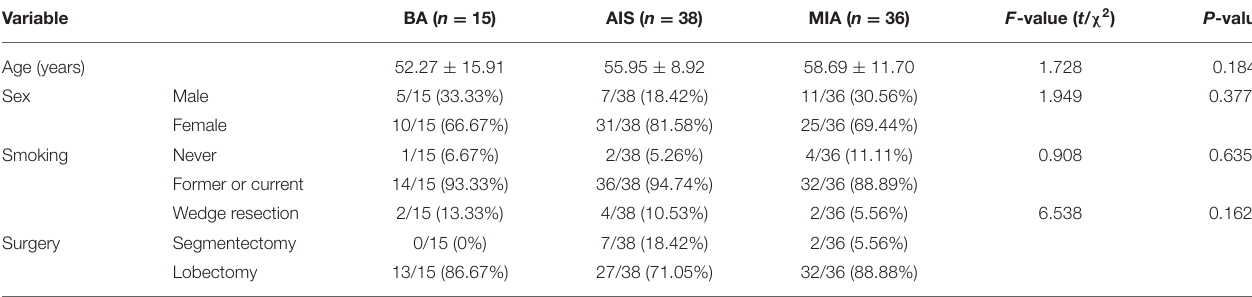
TABLE 1 | Demographic and clinical data of the